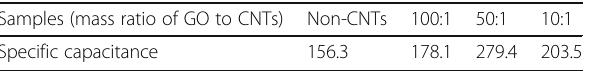
Table 2 Calculated specific capacitance of different electrodes (F/g)